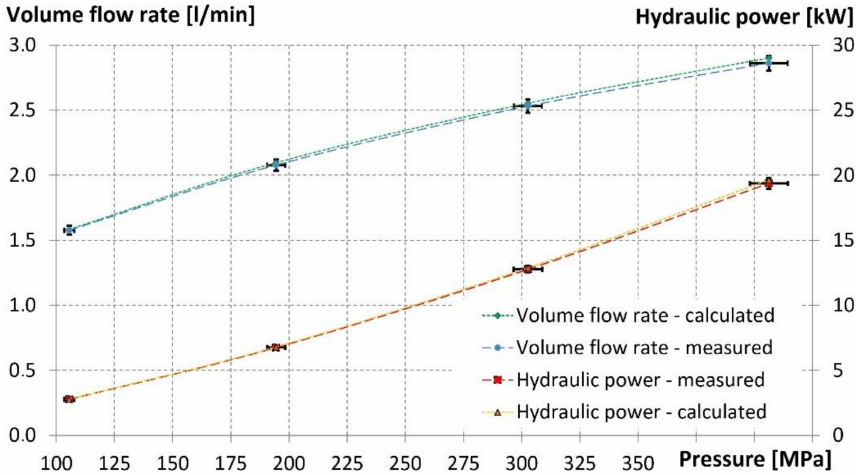
Figure 8. Measured and calculated volume flow rates and hydraulic power at the water nozzle